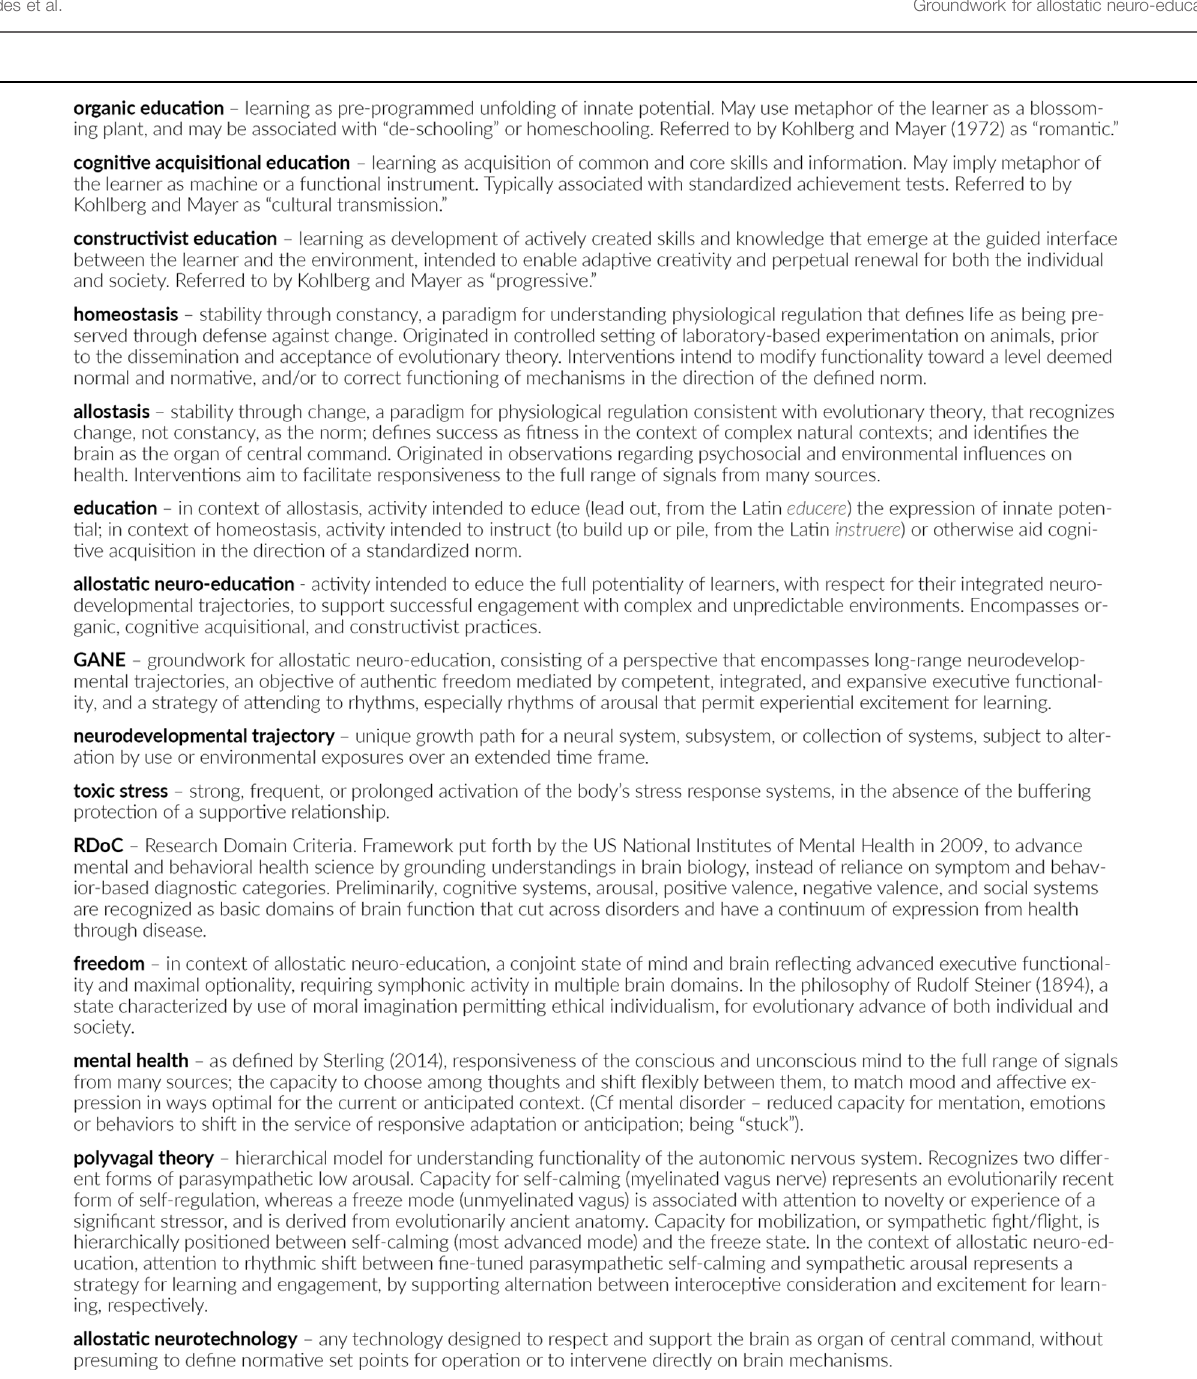
FIGURE 1 | Glossary of terms, concepts, and abbreviations presented in the paper, listed in the order in which they are principally discussed in the